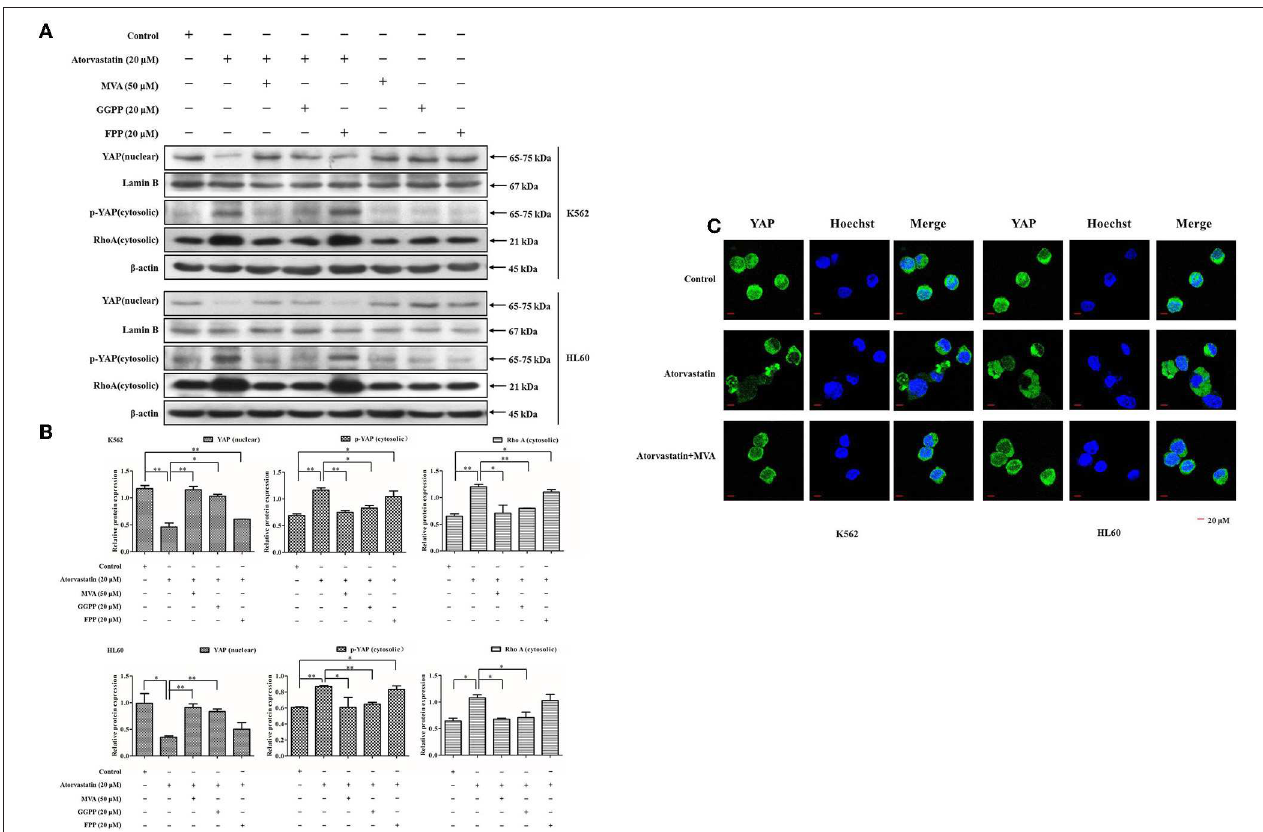
FIGURE 7 | Inactivation of YAP by Atorvastatin is mediated by MVA cascade. K562 and HL60 cells were incubated with Atorvastatin (0 and 20 µ M) in presence or absence of exogenous MVA (50 µ M), FPP (20 µ M), or GGPP (20 µ M) for 48h. (A) The levels of YAP in nucleus, p-YAP (Ser127) and RhoA in cytosol were examined by western blot. (B) Bar graphs show the relative levels of YAP, p-YAP (Ser127), and RhoA. (C) The subcellular localization of YAP was examined by using immunofluorescence and visualized under Olympus laser scanning confocal microscope. The nuclei were counterstained with Hoechst. The representative images were shown. Scale bar, 20 µ m. Data are presented as mean ± SD of three independent experiments. * p < 0.05, ** p < 0.01 vs.